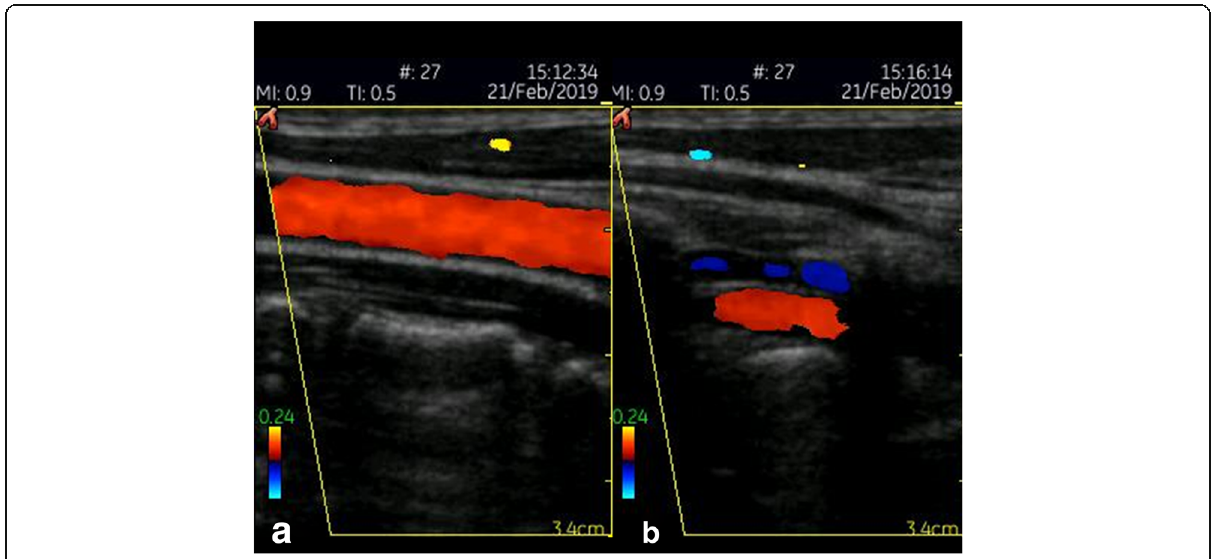
Fig. 4 GE Healthcare VScan (linear array transducer): Colour Doppler image of the carotid ( a ) and vertebral artery ( b )